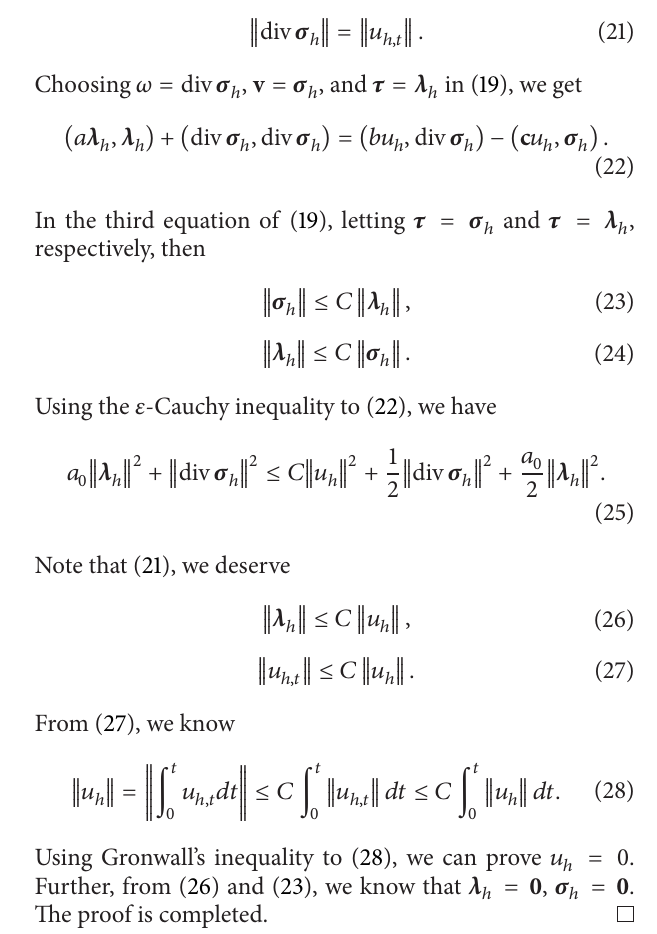
Table 1: Some RT type mixed